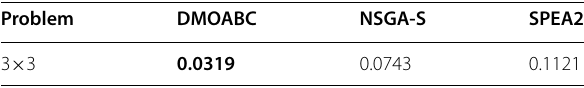
Table 9 C -metric comparison for DMOABC, NSGA-II, and SPEA2 Problem C (DMOABC, NSGA‑C) The optimal values are set in bold font among these three algorithms